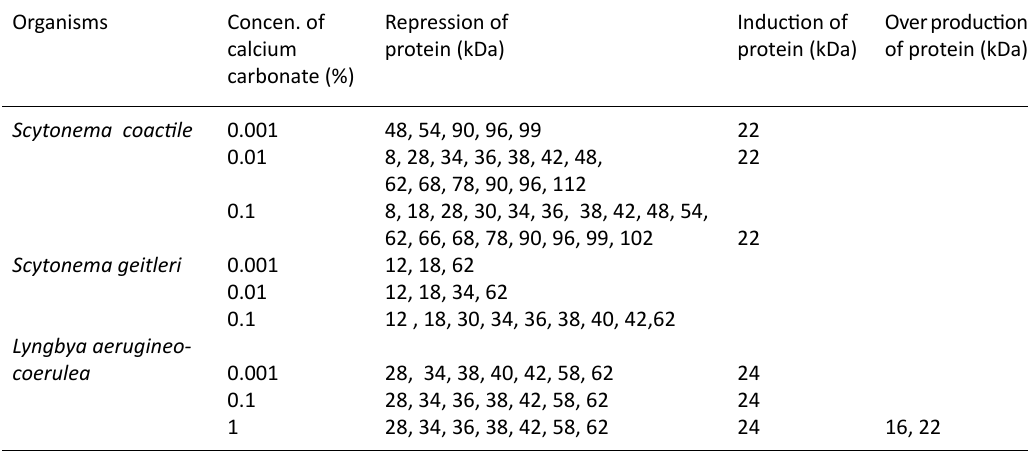
Table 3. Changes in the protein profile of three sub-aerial cyanobacteria strains, Scytonema coactile, S. geitleri and Lyngbya aerugineo-coerulea grown in presence of different concentrations of calcium carbonate (%) under continuous illumination (2000 lux) at 28±2°C up to 15 days Organisms Concen. of Repression of Induction of Over production calcium protein (kDa) protein (kDa) of protein (kDa) carbonate (%) Scytonema